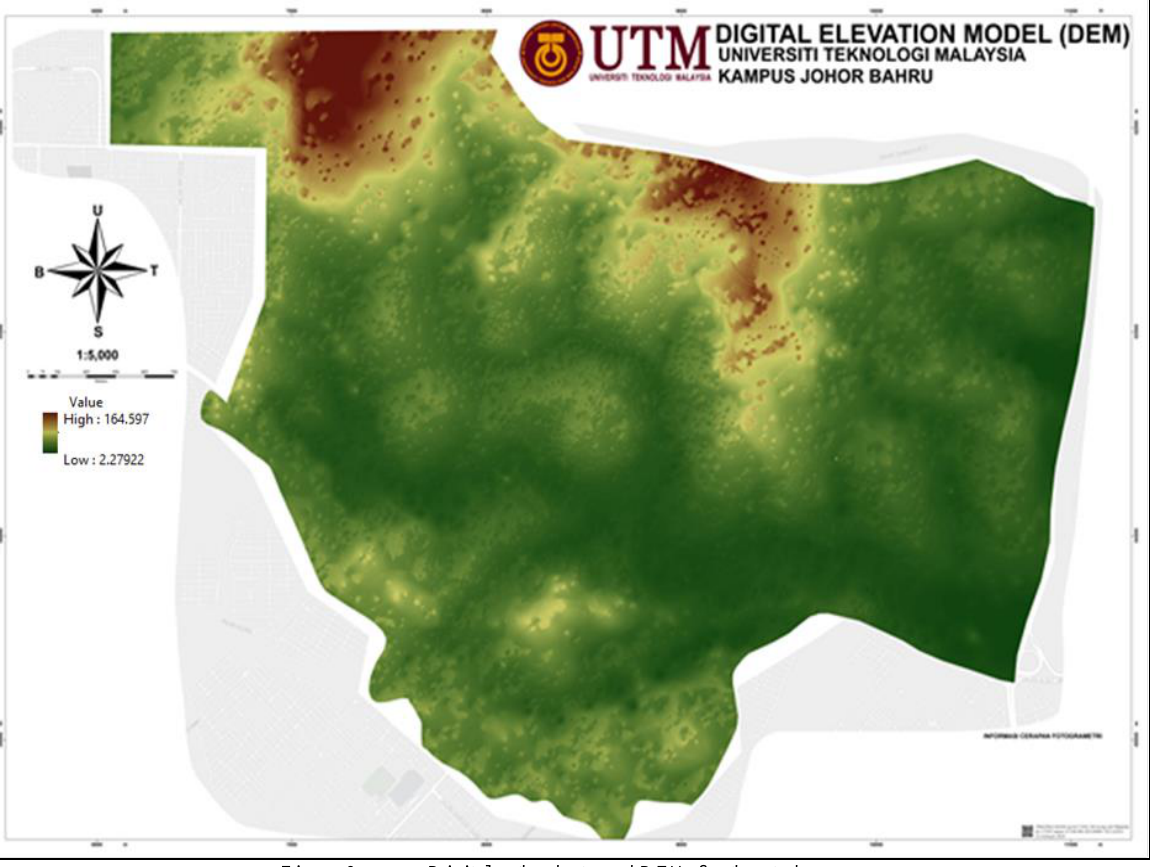
Figure 9 Digital orthophoto and DEM for the study area.